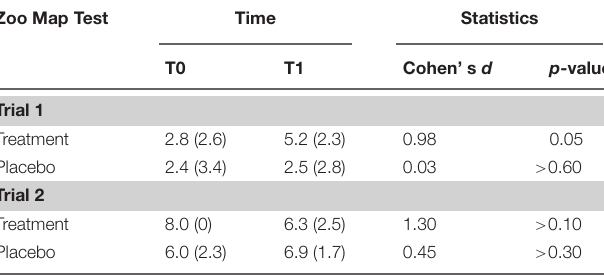
TABLE 3 | Cognitive performances of Parkinson’s disease patients at the beginning (T0) and at the end (T1) of the